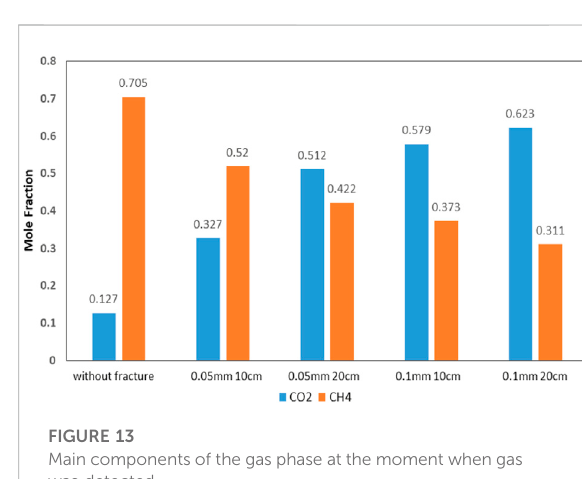
FIGURE 11 Comparison of the recovery degree of different fracture apertures.